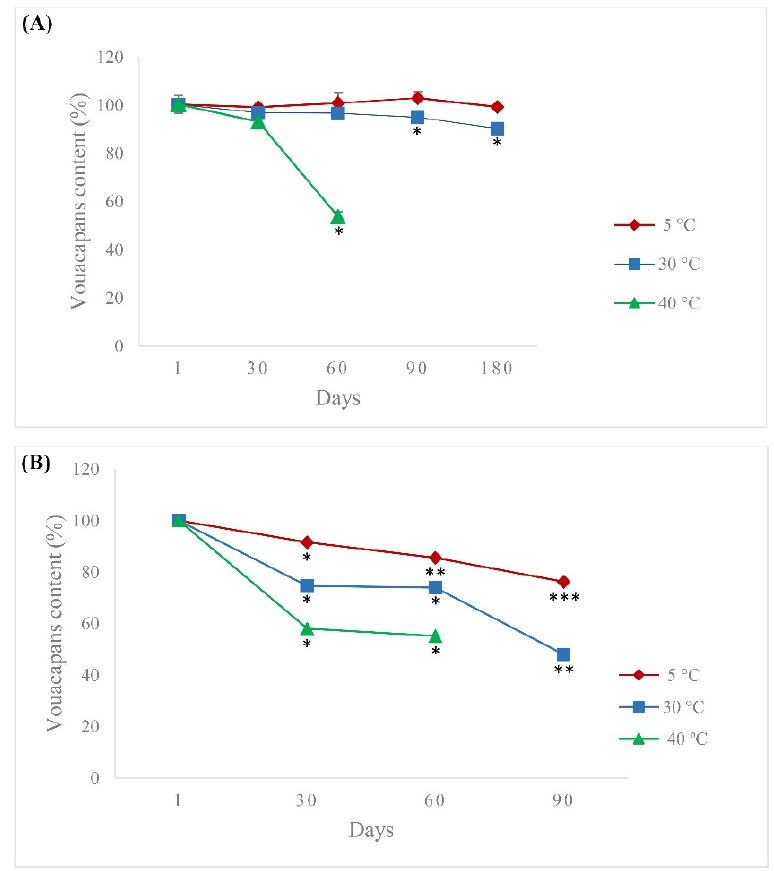
Figure 3. Percentage of recovery of vouacapans of the nanoemulsion ( A ) and free P. pubescens oil ( B ), stored at temperatures of 5, 30, and 40 °C for 180 d. Mean ± SD ( n = 3). One-way ANOVA followed by post hoc Tukey’s test; different specimens (*, **, and ***) are considered statistically different at p < 0.05.